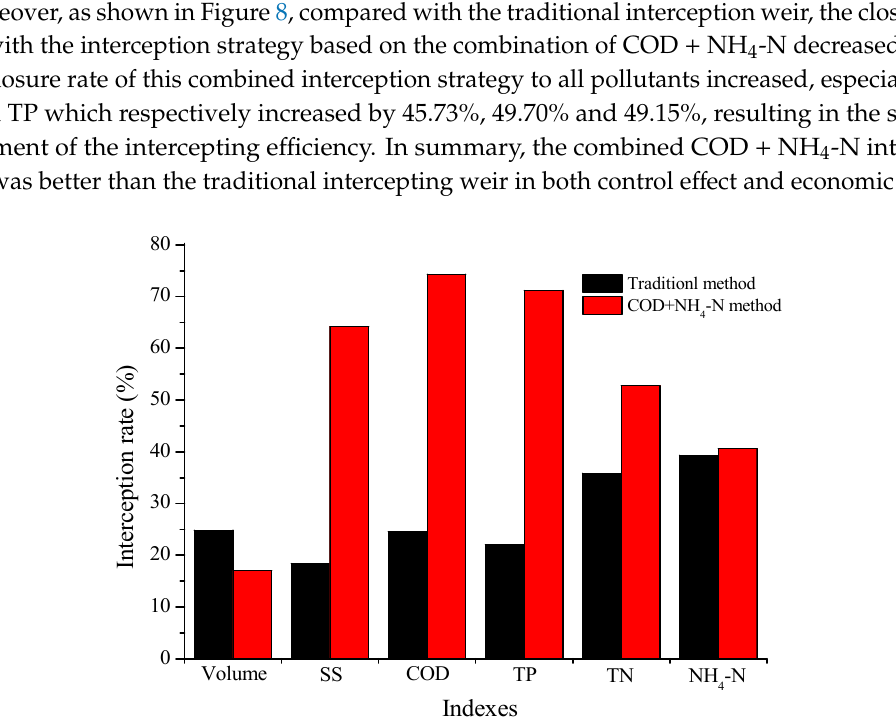
Table 9. Combined results of COD + NH 4 ‐ N.